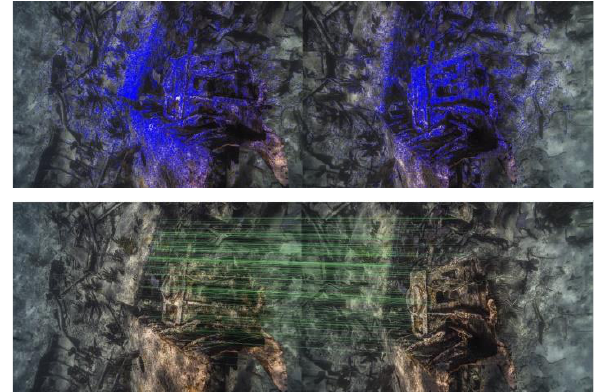
Figure 9. On the top, detected features on the left and right image of the selected stereo couple (in blue); on the bottom, features matched by the FLANN method (in green).